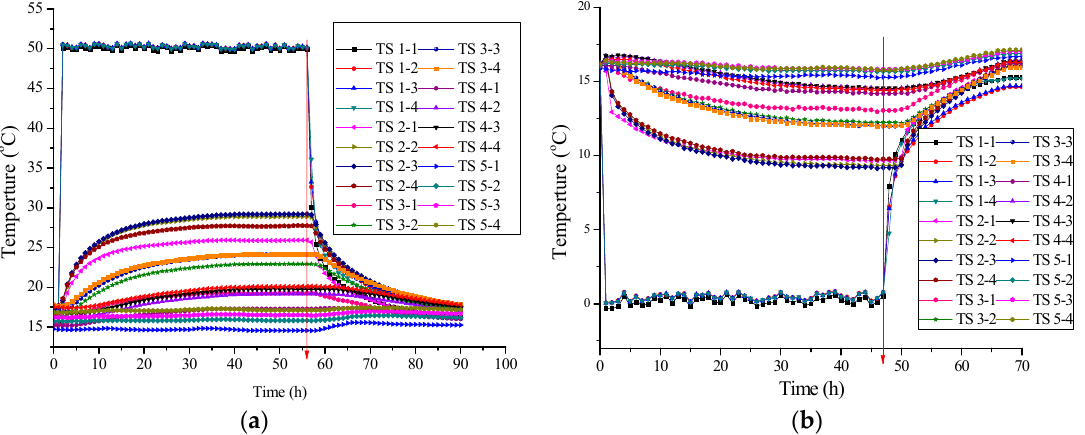
Figure 5. Temperature variations with time of No.3 TSs under a certain temperature fluid circulation: ( a ) 50 °C; ( b ) − 10 °C.